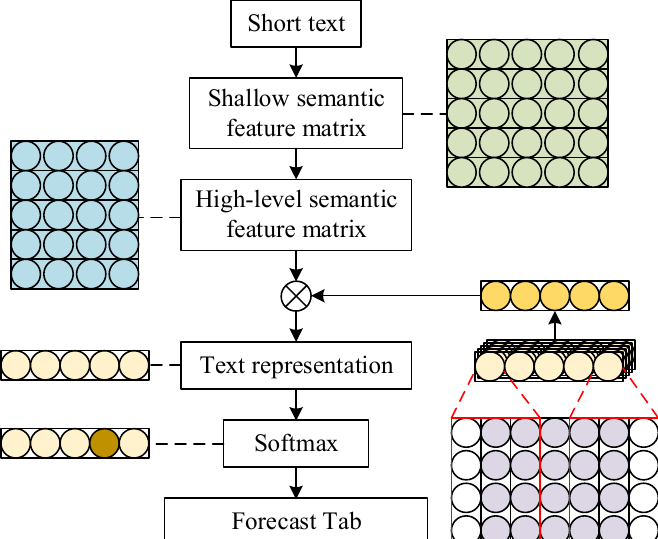
Figure 3. Single-feature S-TC model based on CAM.